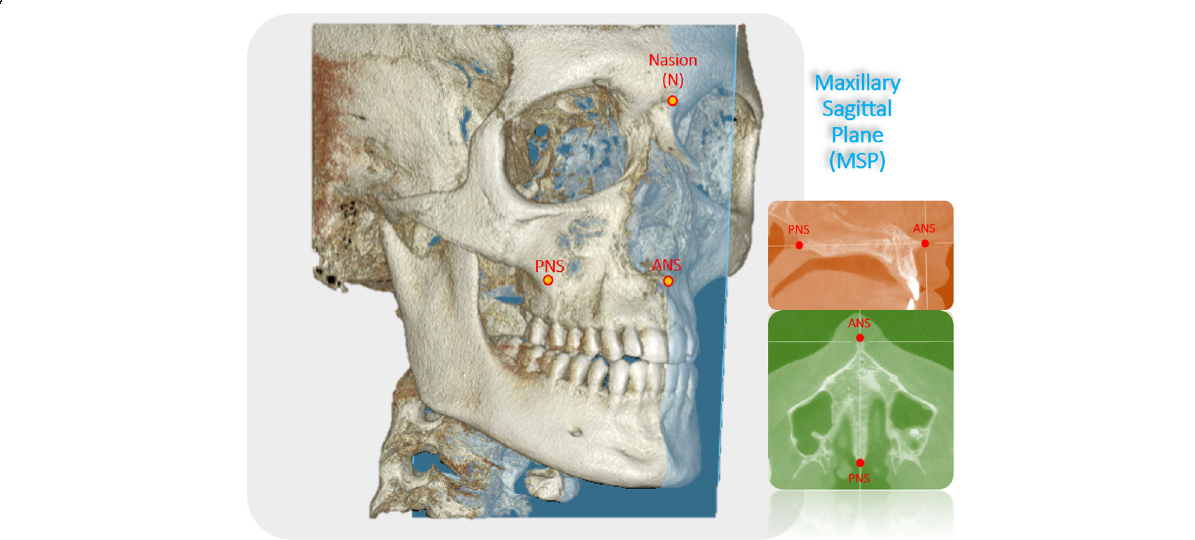
Fig. 4 3D reconstruction with the maxillary sagittal plane (MSP) passing through anterior nasal spine (ANS), posterior nasal spine (PNS), and nasion (N) on the pre-expansion CBCT